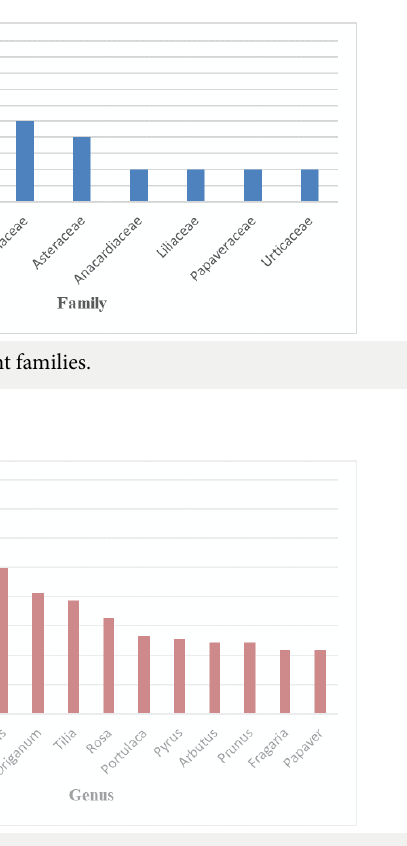
Figure 5 The most frequently used genera, as a percentage.